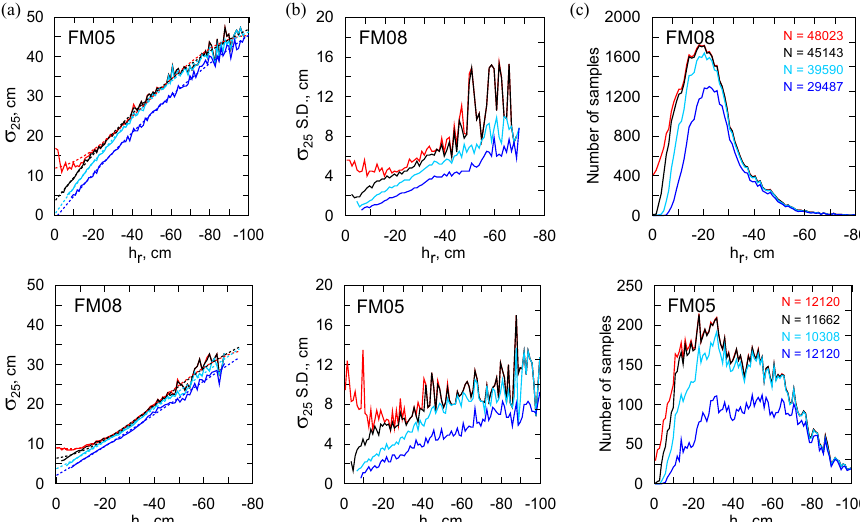
Figure 7. The relationship between h r and σ 25 (a) , distributions of its standard deviations (b) and number of samples in each h r bin (c) for FM05 and FM08 ICESat periods. Red lines are constructed from the selection of samples for which dips in reflectivity are measured, as described in (Kwok et al., 2007). Black, cyan and blue lines are constructed from the new selection of samples we propose in this study, based on requesting the presence of dips in both reflectivity and elevation measurements. Dashed lines correspond to the result of the regression model (cubic polynomial fits) applied to the data (see text for